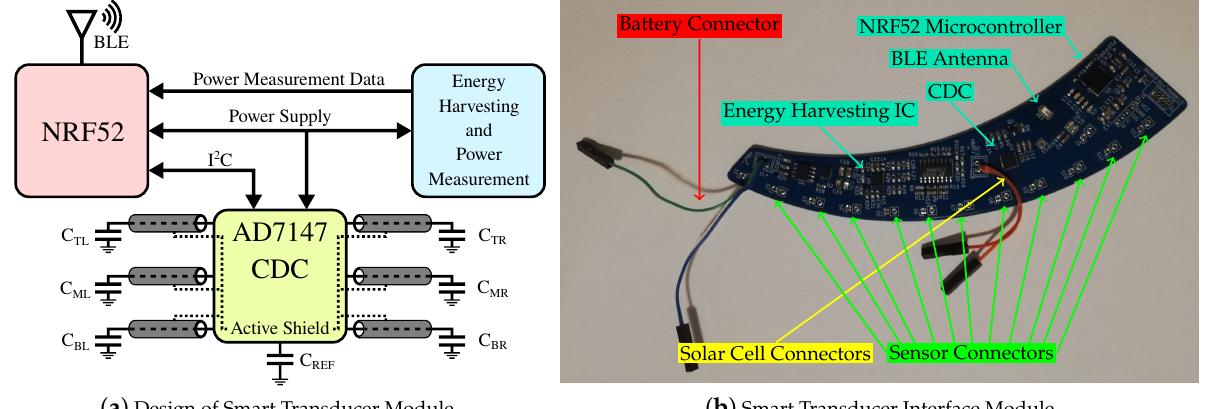
Figure 5. Sensor data acquisition system. Design of STIM is shown in ( a ). The power management harvests energy using solar panels and uses a coin cell as battery backup. NRF52 is used to configure and acquire data from the CDC, which is then transmitted via BLE in compliance with IEEE 1451.0 specifications to the crane controller. ( b ) The fully assembled PCB of the STIM and highlights the various important components related to capacitance measurement, energy harvesting and wireless